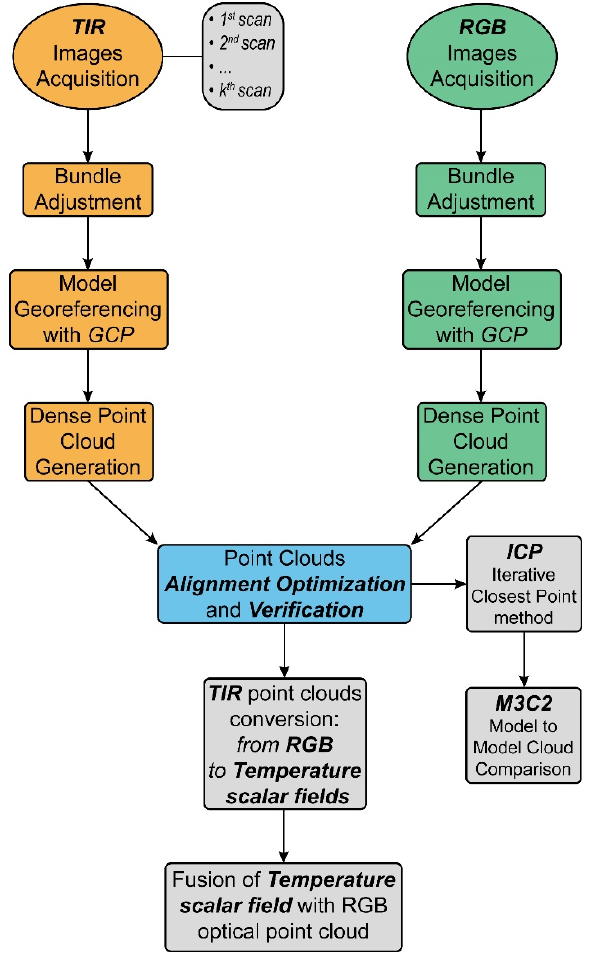
Figure 4. Simplified flowchart representing main steps of the adopted workflow for the generation of the 3D TIR point clouds.